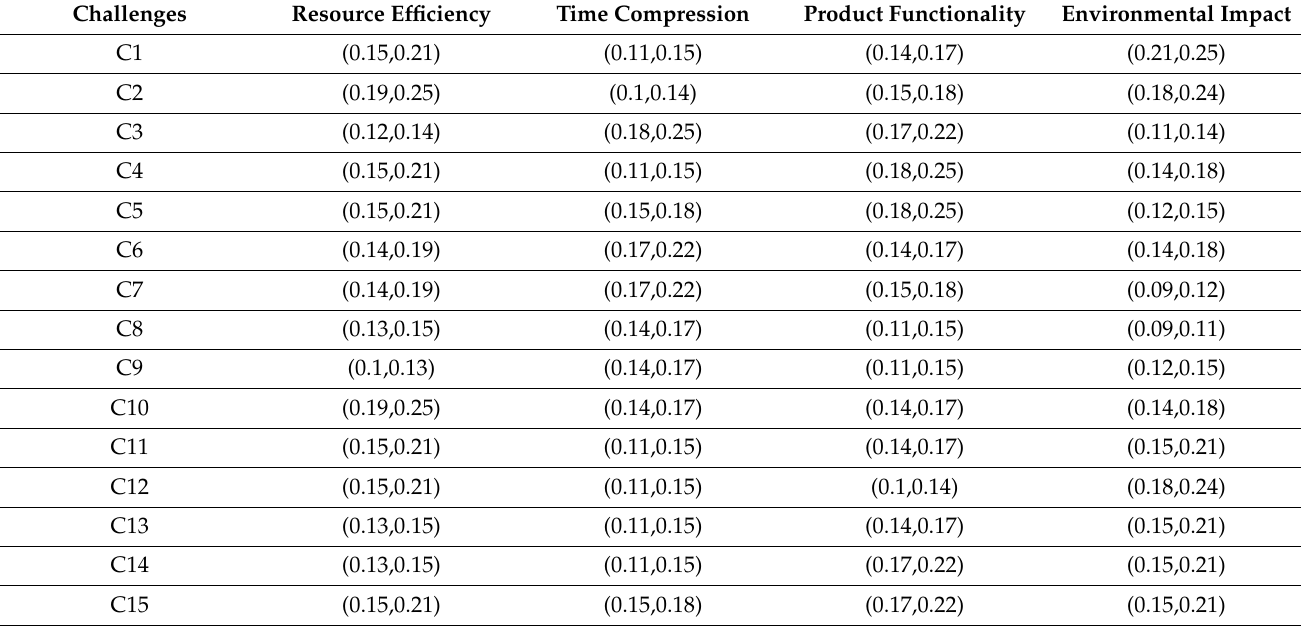
Table 7. Weighted normalized ratings of the